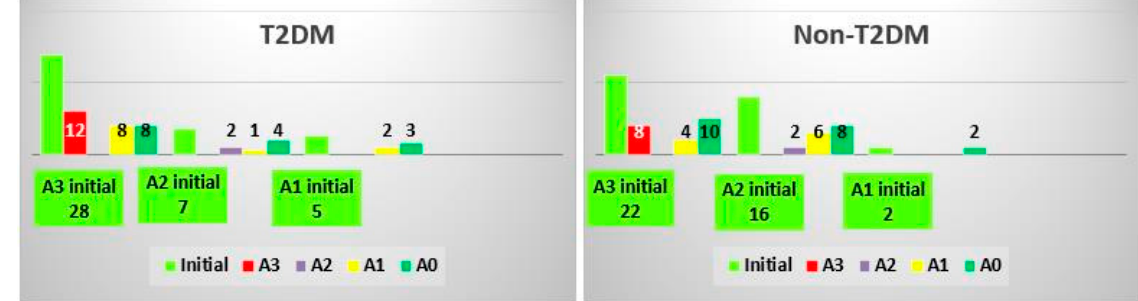
Figure 3. Changes in the ActiTest class after treatment in the T2DM and non-TDM2 groups.